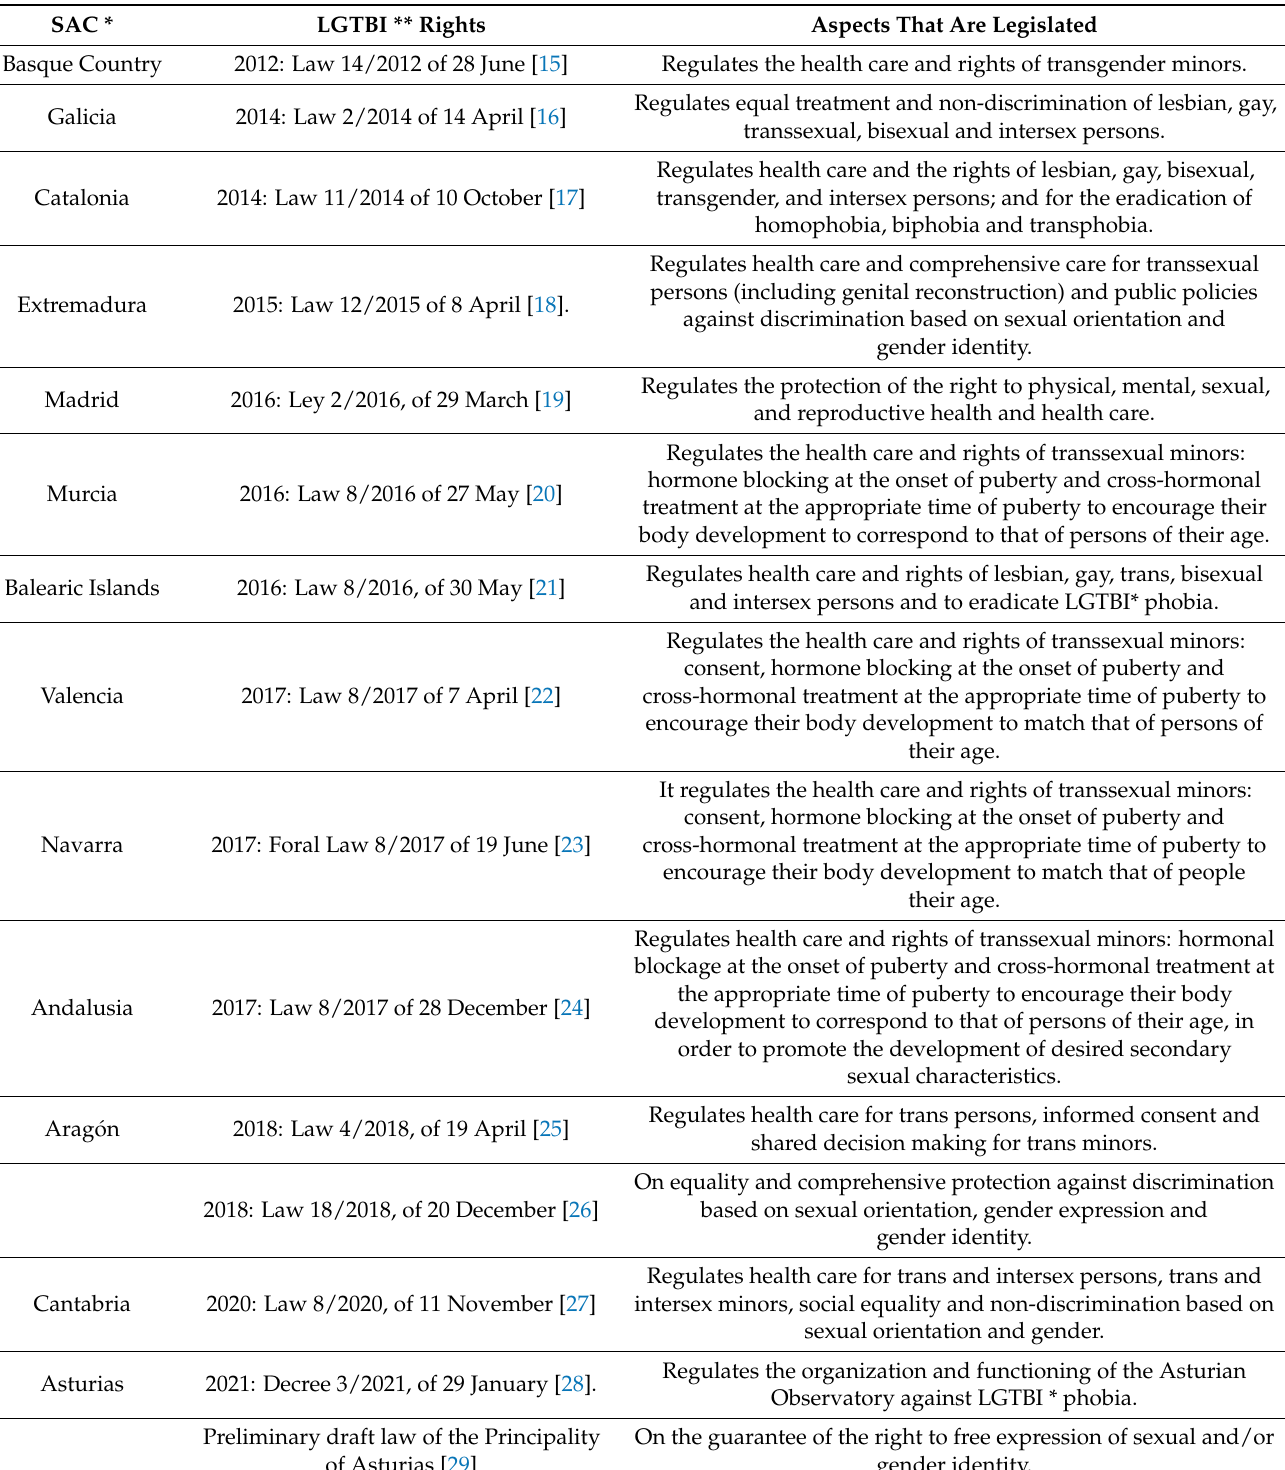
Table 1. Autonomous Community legislation on sexual health care in each Autonomous Community during the period from 2011–2021. Chronological